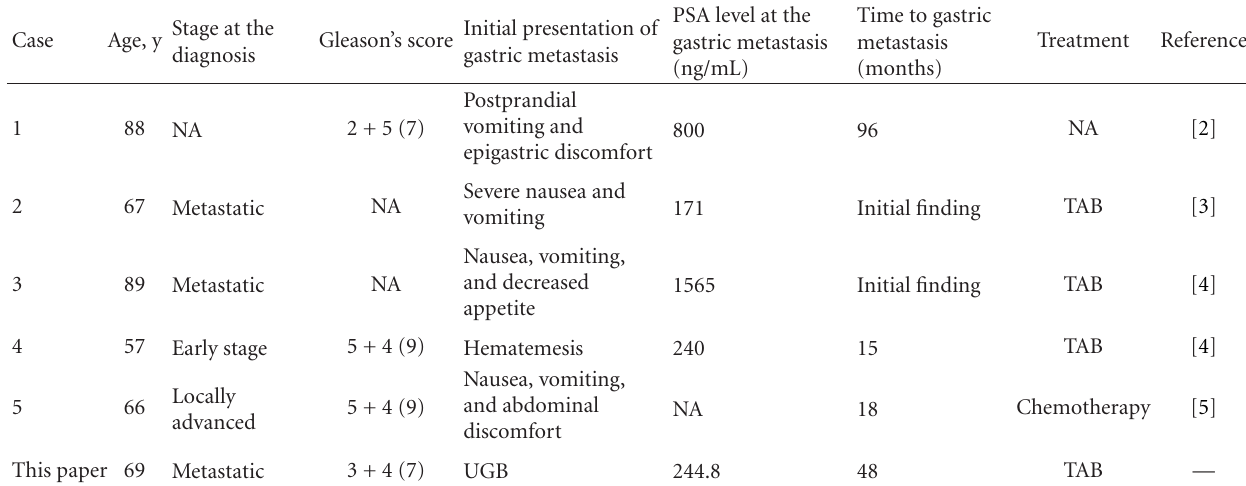
∗ PSA: prostate-specific antigen; TAB: total androgen blockade; UGB: upper gastrointestinal bleeding; NA: not